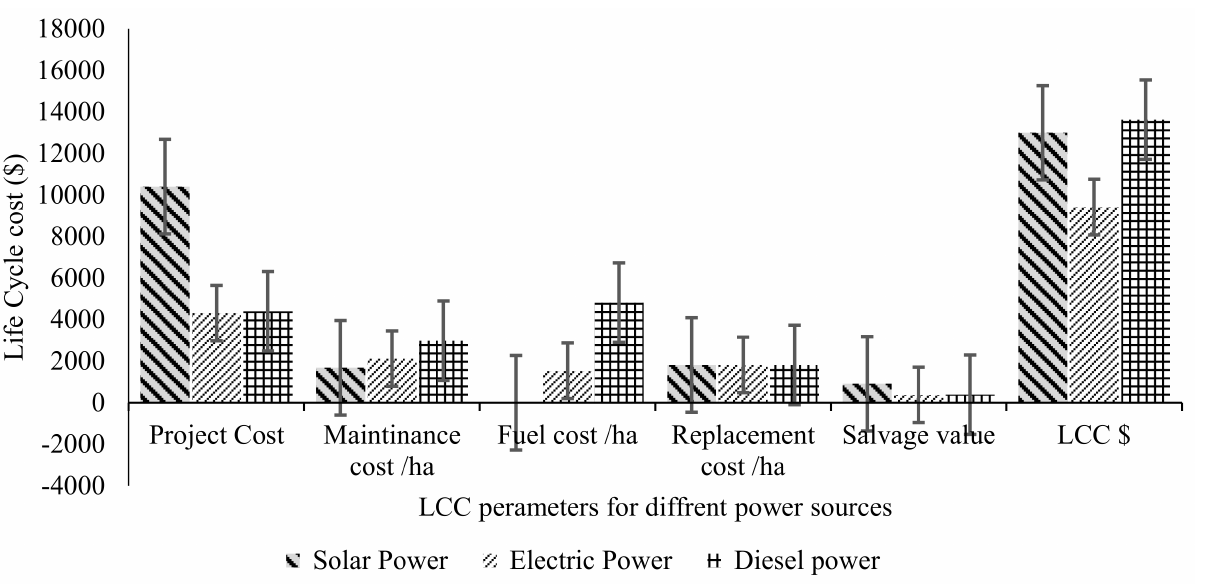
Figure 9. Life cycle cost of different power sources for drip irrigation systems. Solar drip irrigation systems have the highest capital cost, which is approximately 6000 more than the other two sources, whereas diesel and electric power sources have nearly equal capital costs. Figure 10 also shows that diesel has higher maintenance and fuel costs, whereas solar power DIS has zero fuel cost. In the end, there is a nonsignificant difference in the LCC of solar and diesel power drip irrigation systems. Even diesel has a higher LCC than solar, which shows the capital cost of solar takes 15 years to be equal to the diesel power source.